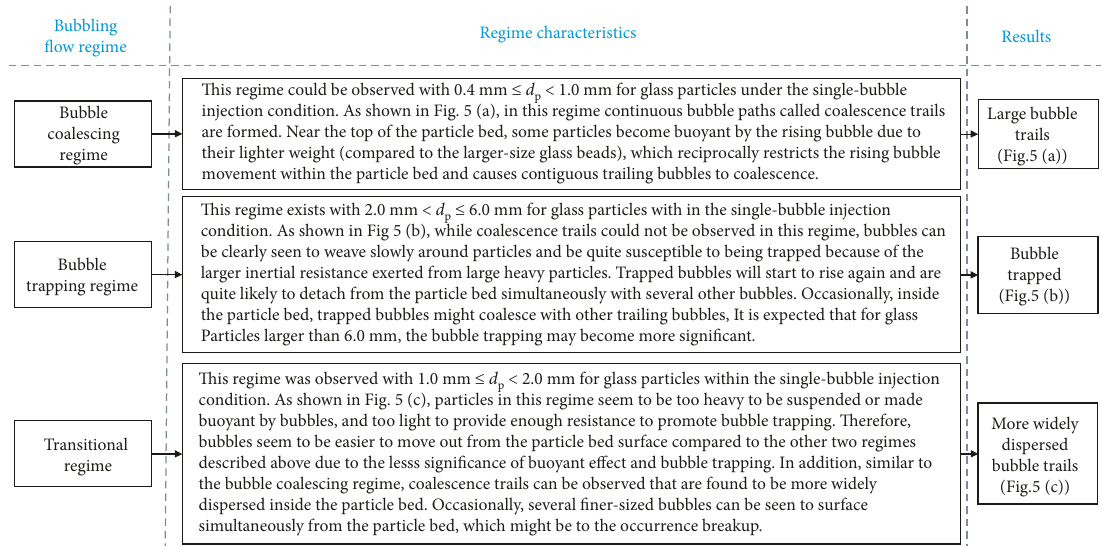
Figure 6: Flow regime characteristics of bubble behaviors within glass spherical particle beds in the